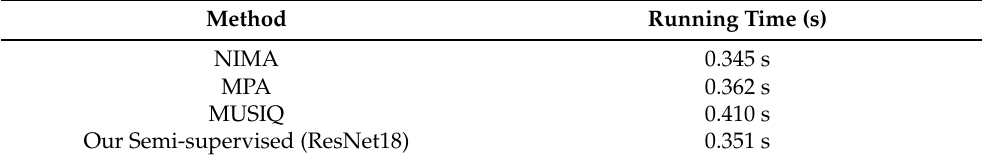
Table 10. Comparison of image forward pass running time for different methods (ResNet18